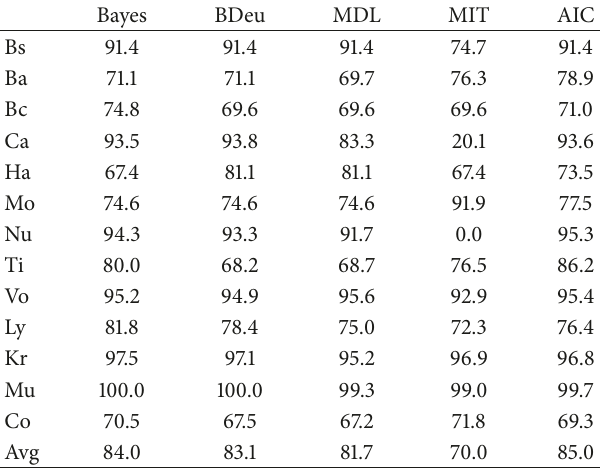
Table 12: Performance comparison of BNs learned by different scoring functions.